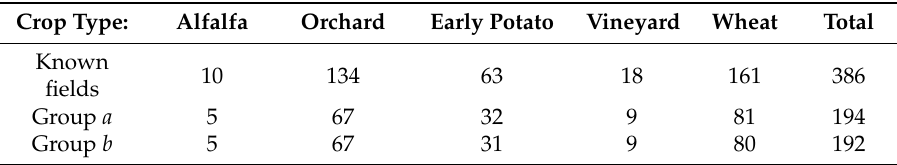
Table 1. Subdivision of the known fields per crop type for classification.